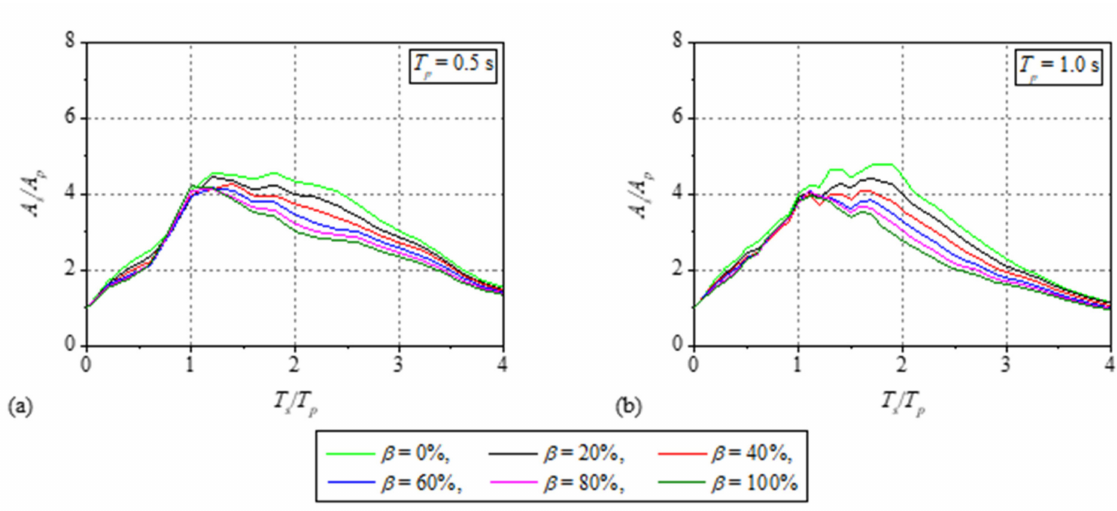
Figure 4. Effect of energy dissipation parameter β on mean normalized floor response spectra for a SC system with R = 6, post-yield stiffness ratio α = 5%; viscous damping ratio ξ p = 5%; and a secondary structure with viscous damping ratio ξ s = 5%: ( a ) T p = 0.5 s; and ( b ) T p = 1.0 s.